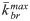
Time courses of F-actin (F) and Las17 (N) of wild-type and las17 pan1Δacidic (LPΔA) cells.(A) Time courses of F and N obtained from the ME model, compared to experimental data [12] for wild-type cells. (B) Same comparison for LPΔA cells, in which k¯brmax is reduced by 40%.